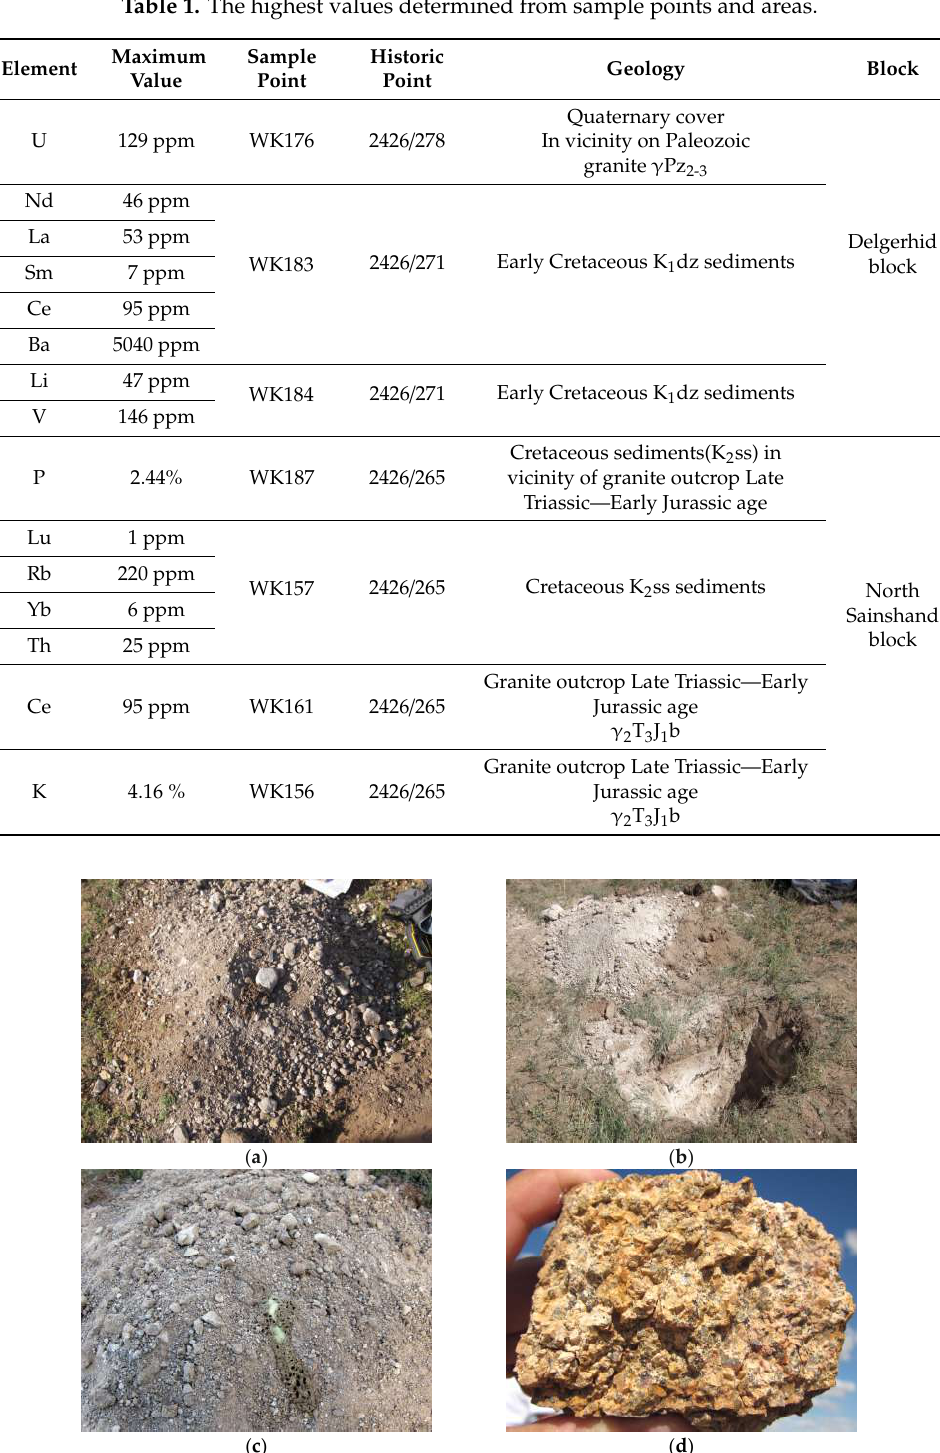
Figure 6. ( a ) WK183 light grayish-brown carbonaceous conglomerate with loose pebbles; ( b ) WK184 brownish-gray fine-grained sand, whitish-gray siltstone and dark to light gray siltstone; ( c ) WK161 brown sand with granite fragments clasts; yellow in the center is the reaction of nitric acid and ammonium molybdate with phosphorus in the sample; ( d ) WK157 coarse-grained granite, Late Triassic—Early Jurassic age.